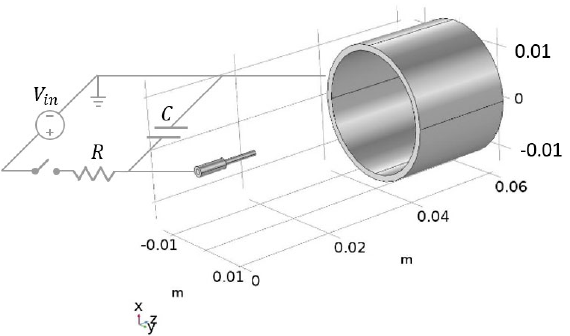
Figure 1. EHD thruster geometry: the needle-type anode on the left side and the cylindrical cathode on the right side, with typical dimensions and the RC coupling circuit.